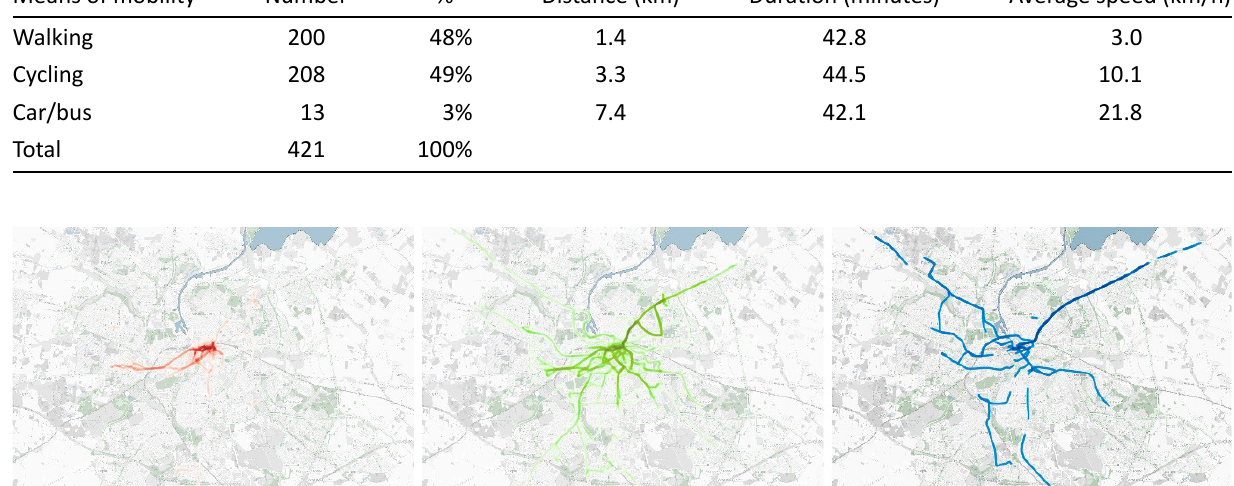
Figure 2. Maps of density/kernel distribution of points on the move. Notes: From left to right, we have, in red, walking (see details in Figure 3); in green, cycling/running; and, in blue, car/public